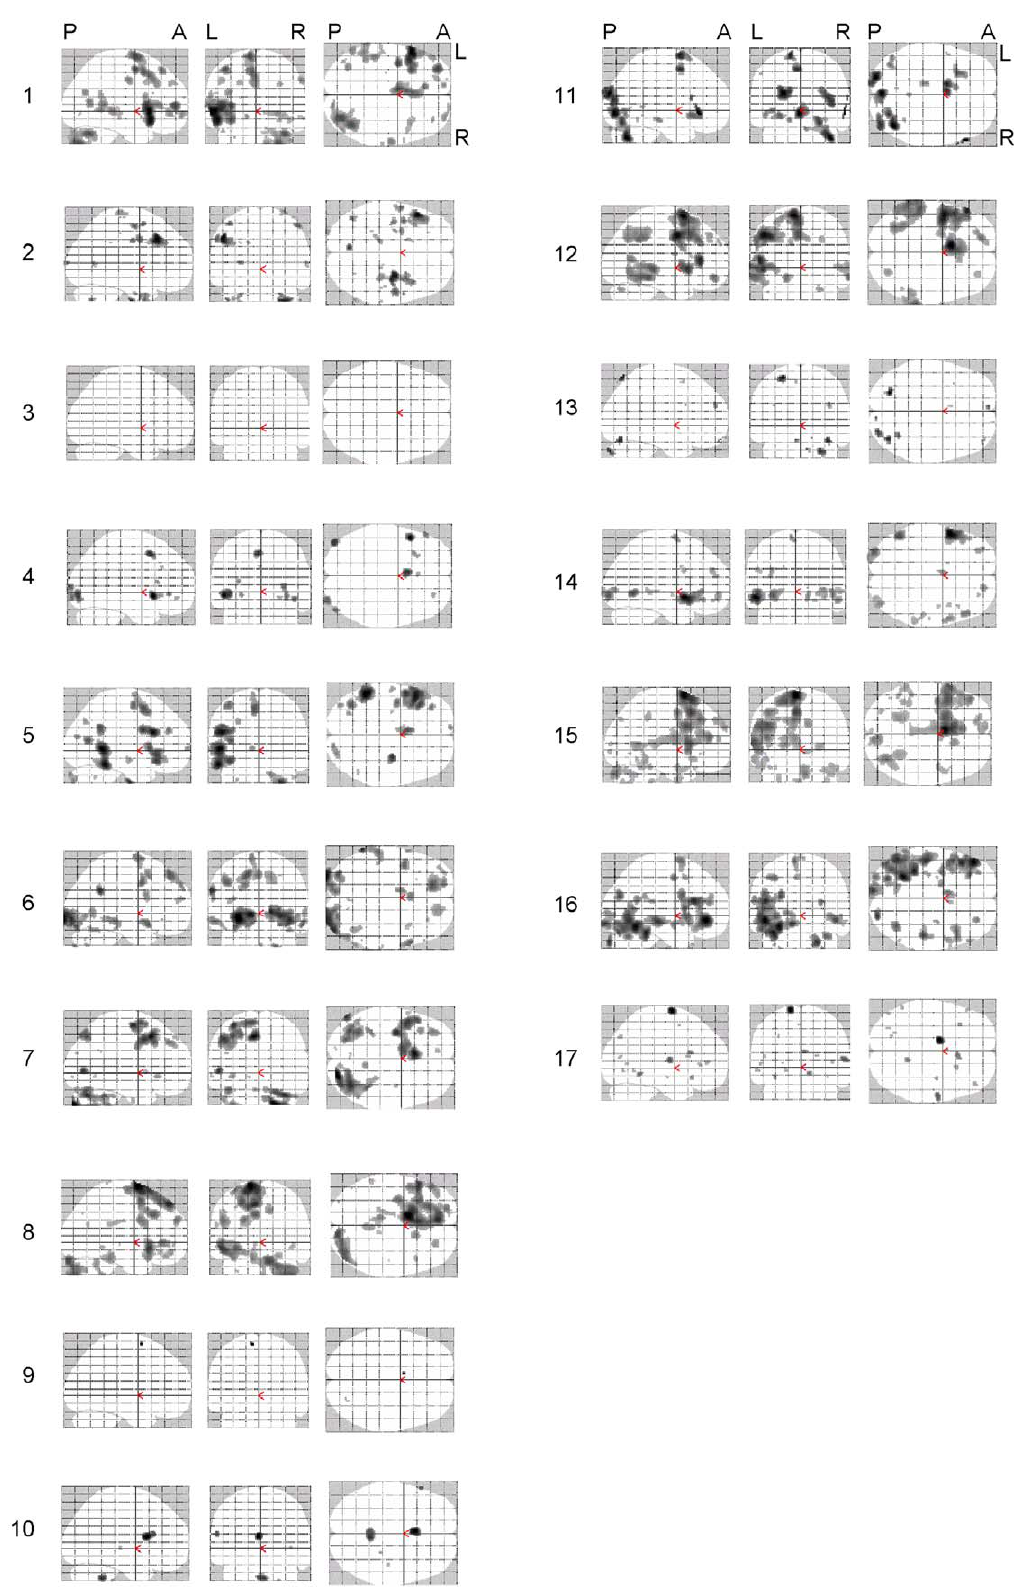
Figure 1. Maximum Intensity Projections (MIP) of fMRI data for subject 1 to 17 in the verb-generation paradigm at p , 0.001 uncorrected. Spatial orientation of all projections is shown on the top row (P=posterior, A=anterior, L=left, R=right).